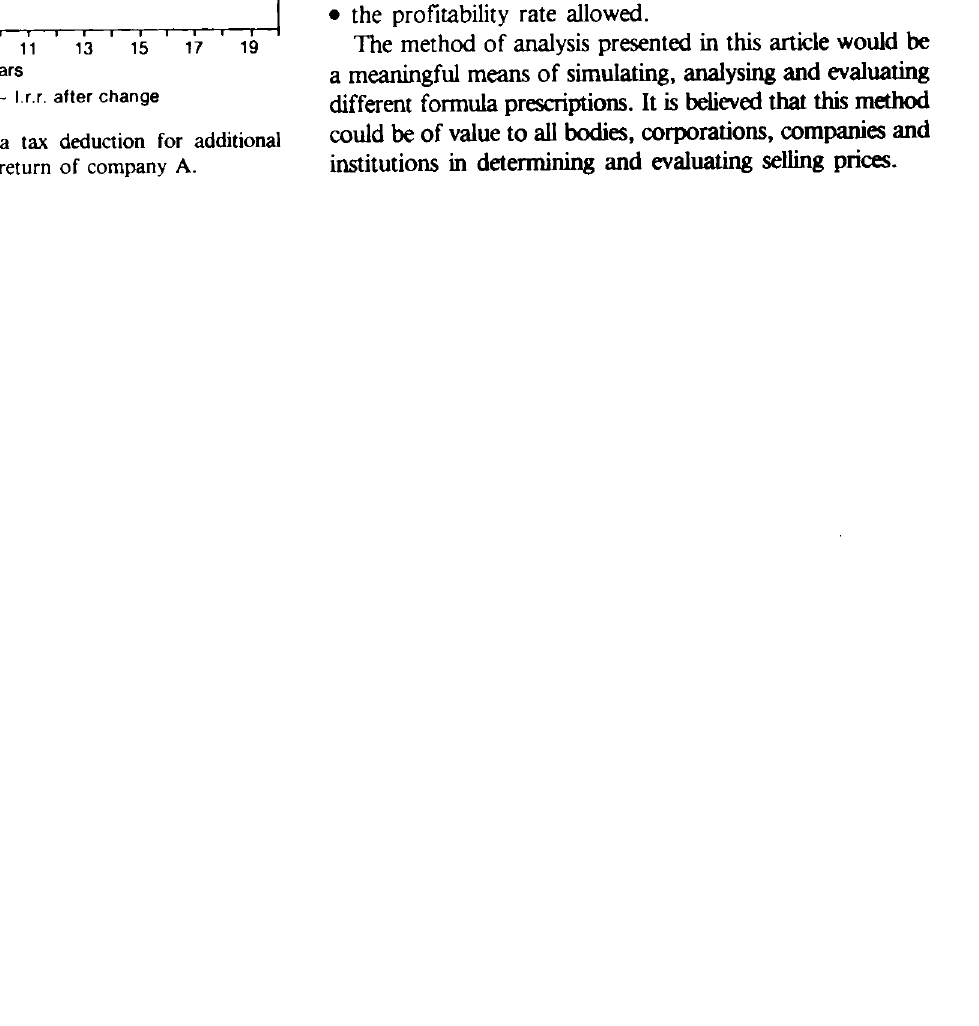
Figure 4 The effect of including a tax deduction for additional depreciation on the internal rate of return of company